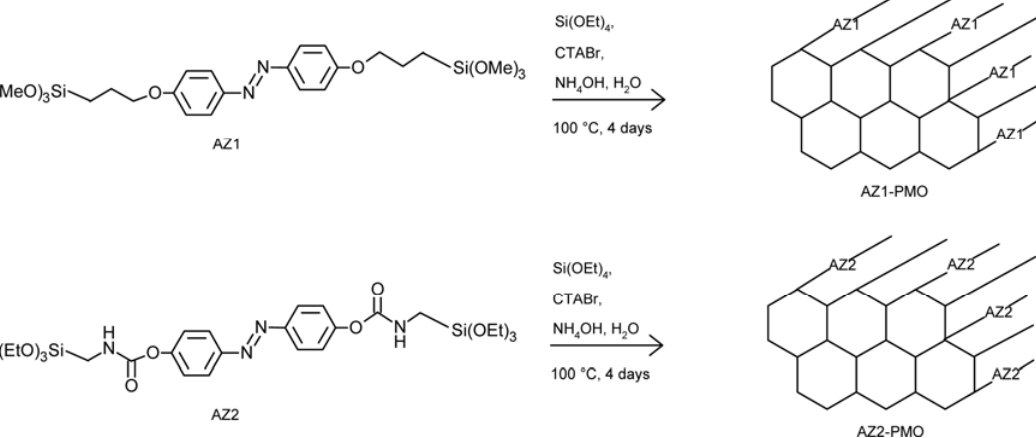
Figure 25. Synthesis paths for AZ1-PMO ( top ) and AZ2-PMO ( bottom